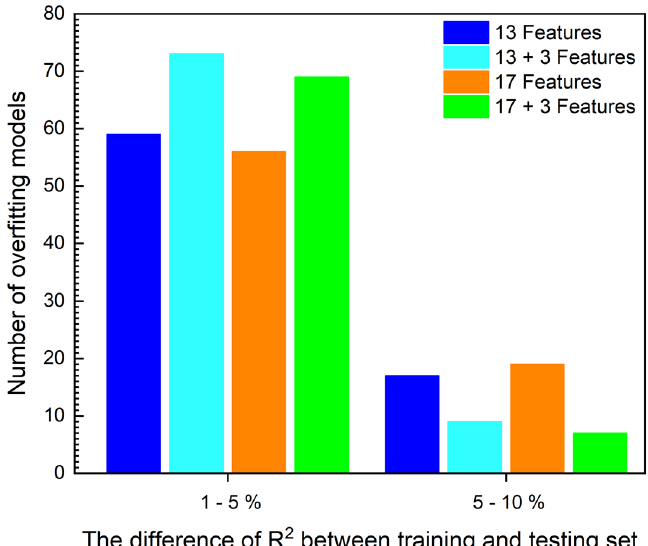
Figure 6. The number of overfitting ML models with/without characteristic temperatures.